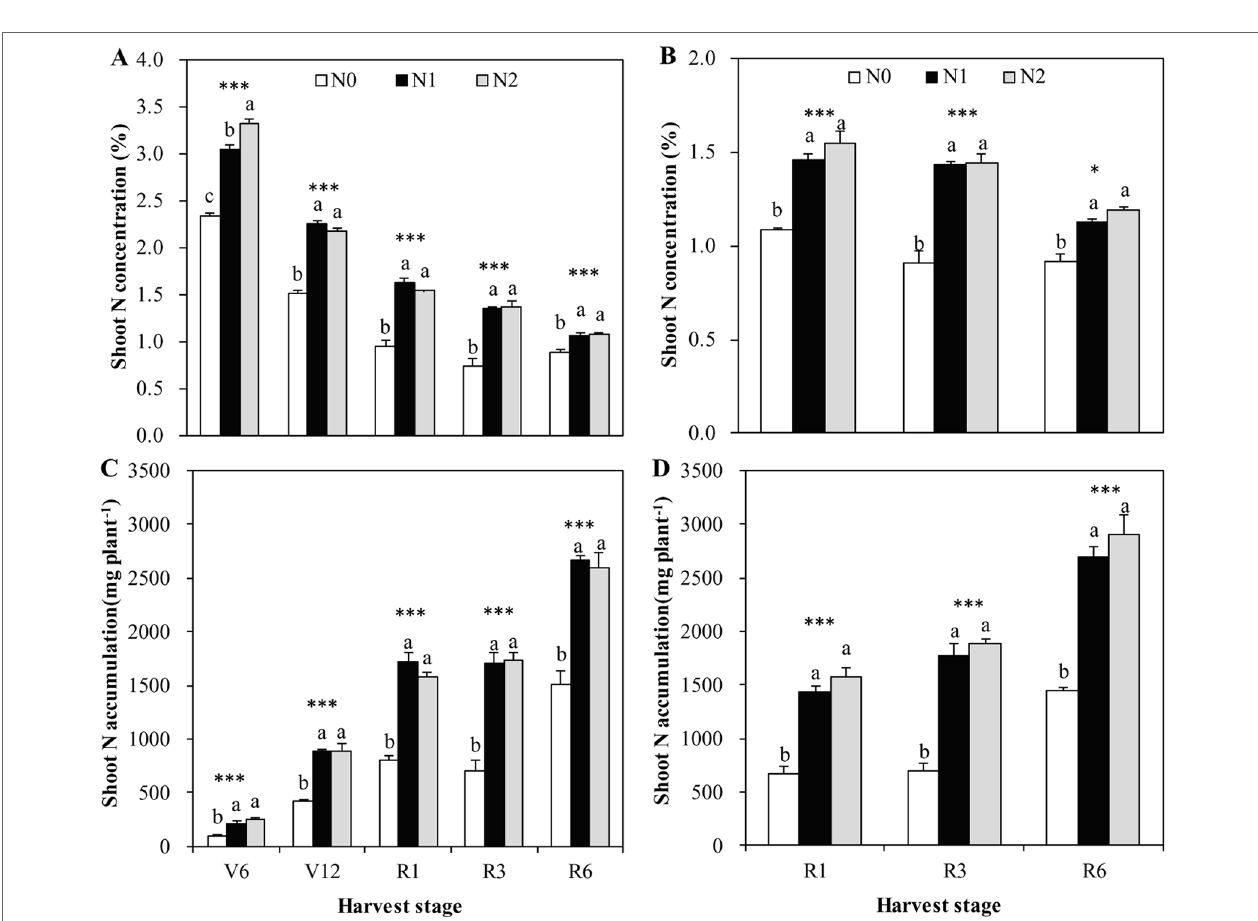
FIGURE 2 | The shoot N concentration and accumulation of summer maize at V6, V12, R1, R3, and R6 growth stages as affected by N application rates in the field in 2009 (A , C) and 2010 (B , D) , respectively. The error bars represent the standard error of the mean ( n = 4 in 2009 and n = 3 in 2010). For each stage, bars with same lowercase letters are not significantly different in different N treatments (P < 0.05). ns indicates no significant difference. * and *** indicate significant difference at P < 0.05, and < 0.001,